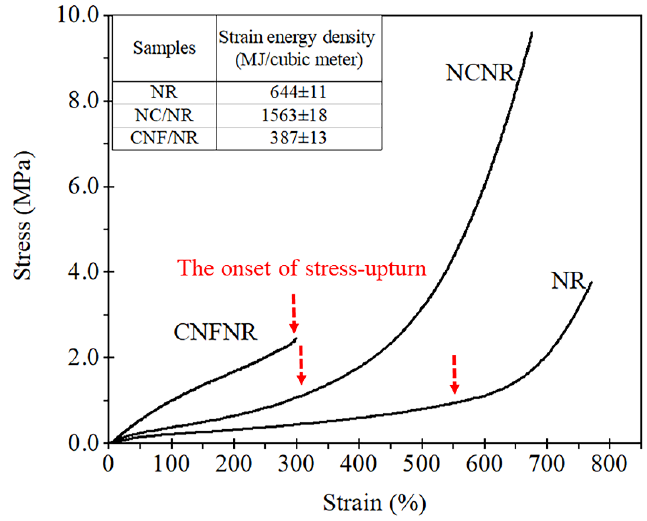
Figure 4. Stress–strain curves of NR, NC/NR, and Figure 4. Stress – strain curves of NR, NC/NR, and CNF/NR.